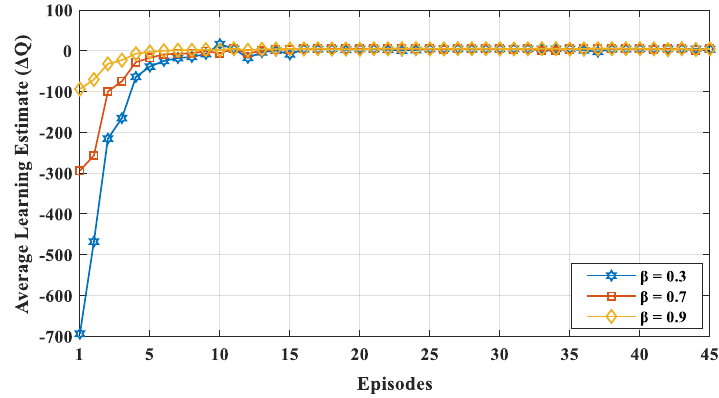
Figure 5. Convergence of learning estimate 𝛥𝑄 for varying the discount factor 𝛽 ( 𝛼 = 0.7, ∊ = 0.7).